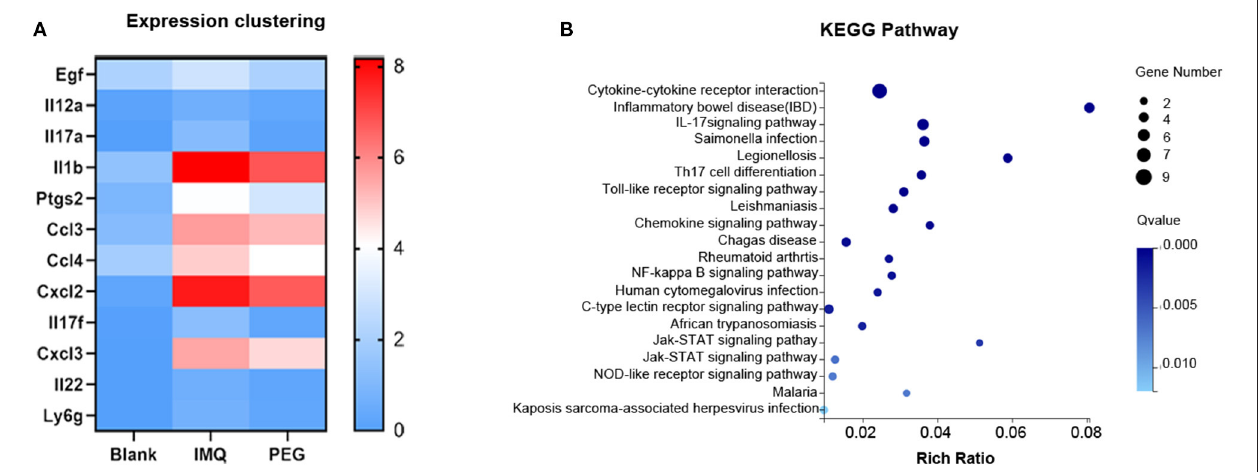
FIGURE 4 | (A) Expression clustering heat map; the horizontal axis represents the log2 (FPKM + 1) of the sample, and the vertical axis represents the gene. Under the default color scheme, the redder the color, the higher the expression level, and the bluer the color, the lower the expression level. (B) KEGG Pathway enriches the bubble chart; the X -axis is the enrichment ratio, and the Y -axis is the KEGG Pathway. The size of the bubble indicates the number of genes annotated to a KEGG Pathway. The color represents the enriched Q value. The darker the color, the smaller the Q value.